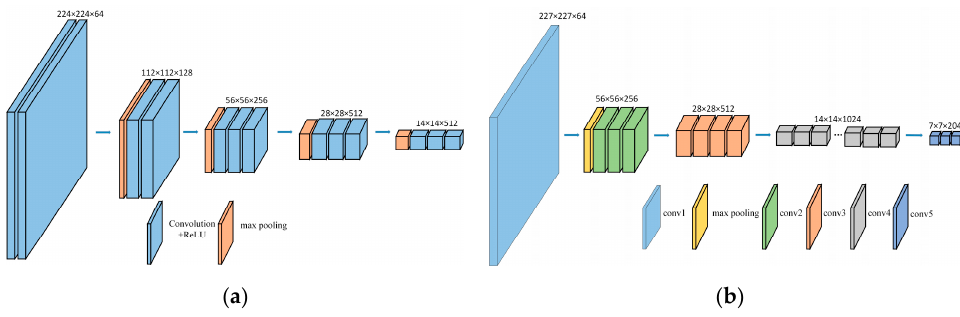
Figure 5. Convolutional Neural Network (CNN) network structure: ( a ) VGG16; ( b ) ResNet50.